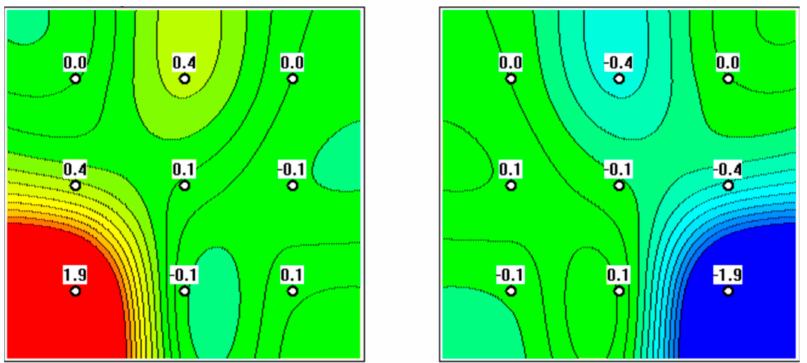
Figure 3. MWR performed on a 69-year-old patient. Focal hyperthermia in the projection of the right ovary is evident, putting the patient in the high-risk group.